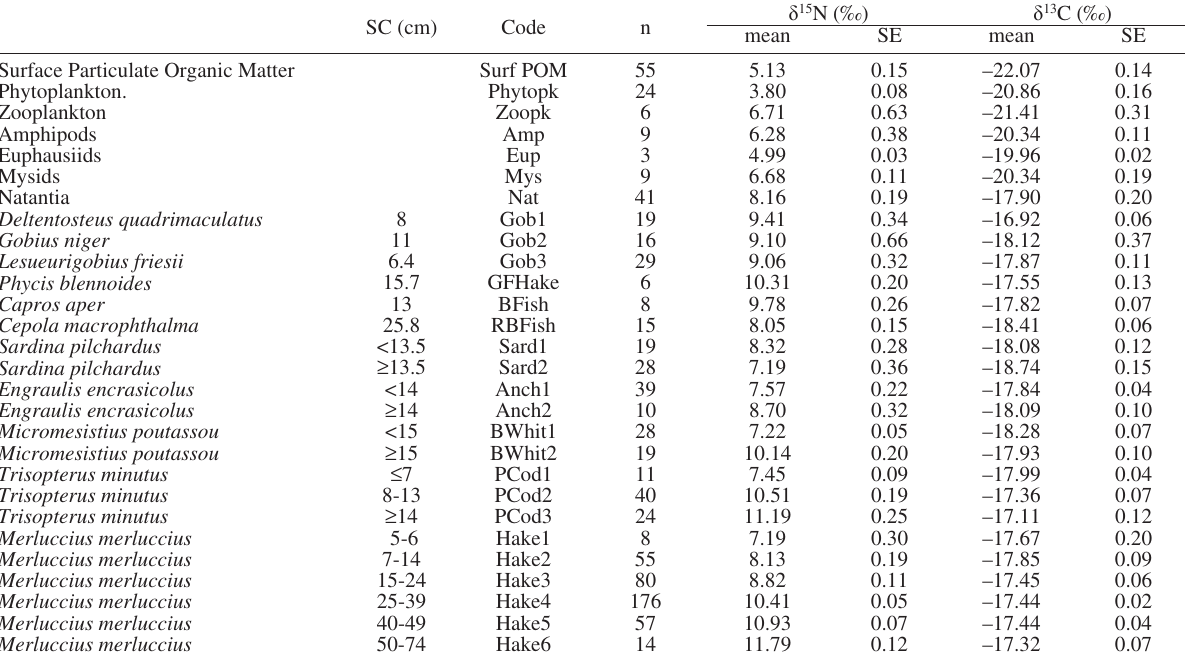
Table 4. – Mean isotopic signature with standard error (SE) by size class (SC) in the GoL in 2005.